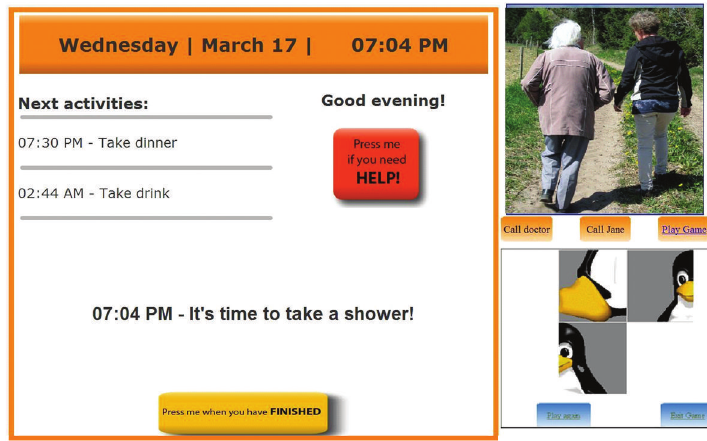
Figure 1: Screen shot of the Carebox with the Help and Confirmation button from the Reminders Service and Memory Lane and Brain